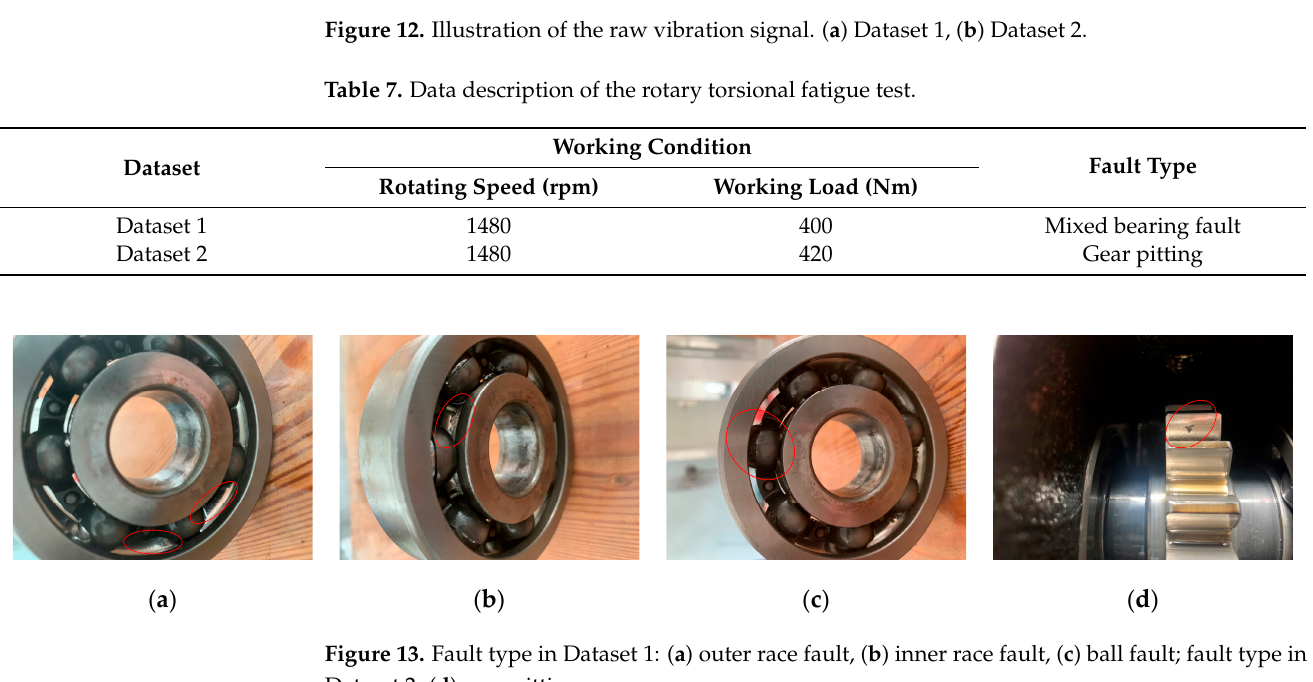
Figure 13. Fault type in Dataset 1: ( a ) outer race fault, ( b ) inner race fault, ( c ) ball fault; fault type in Dataset 2: ( d ) gear pitting